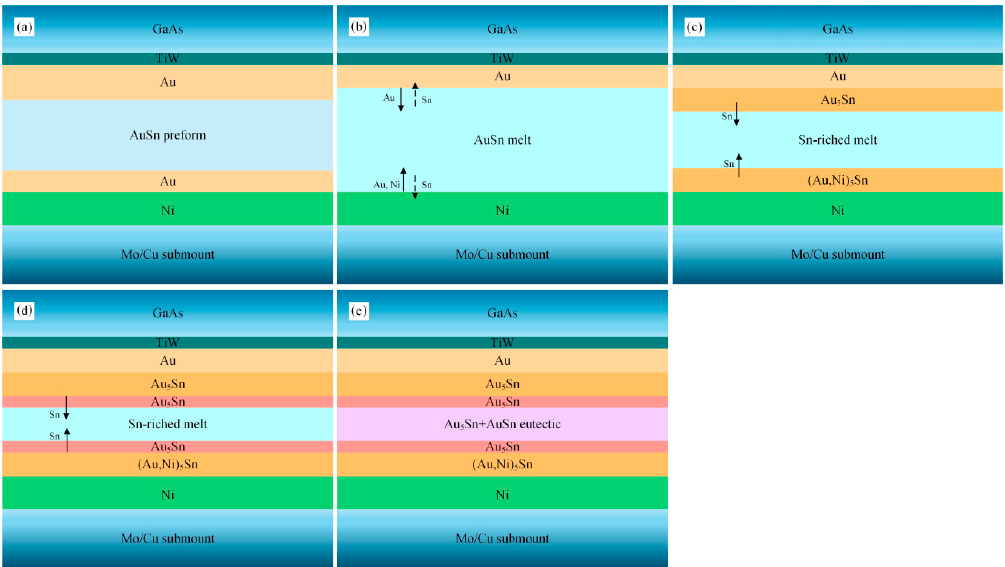
Figure 8. Schematic diagram of the microstructure evolution process of the TiW/Au|Au-Sn joint: ( a ) initial state, ( b ) dissolution and diffusion between the metallization system and the Au-Sn solder, ( c ) isothermal solidification with the formation of Au 5 Sn, ( d ) nonisothermal solidification with the formation of Au 5 Sn, and ( e ) nonisothermal solidification with the formation of Au-Sn eutectic. A deviation of 1 wt.% Au from the eutectic composition towards the Au-rich side results in an approximately 30 °C increase in the liquidus temperature [21]. Due to the uneven spreading of the filler metal, some area of the brazed region locally lacked melting Au-Sn solder. The Au layer dissolved into the melting solder, resulting in an obvious local increase of Au. Therefore, isothermal